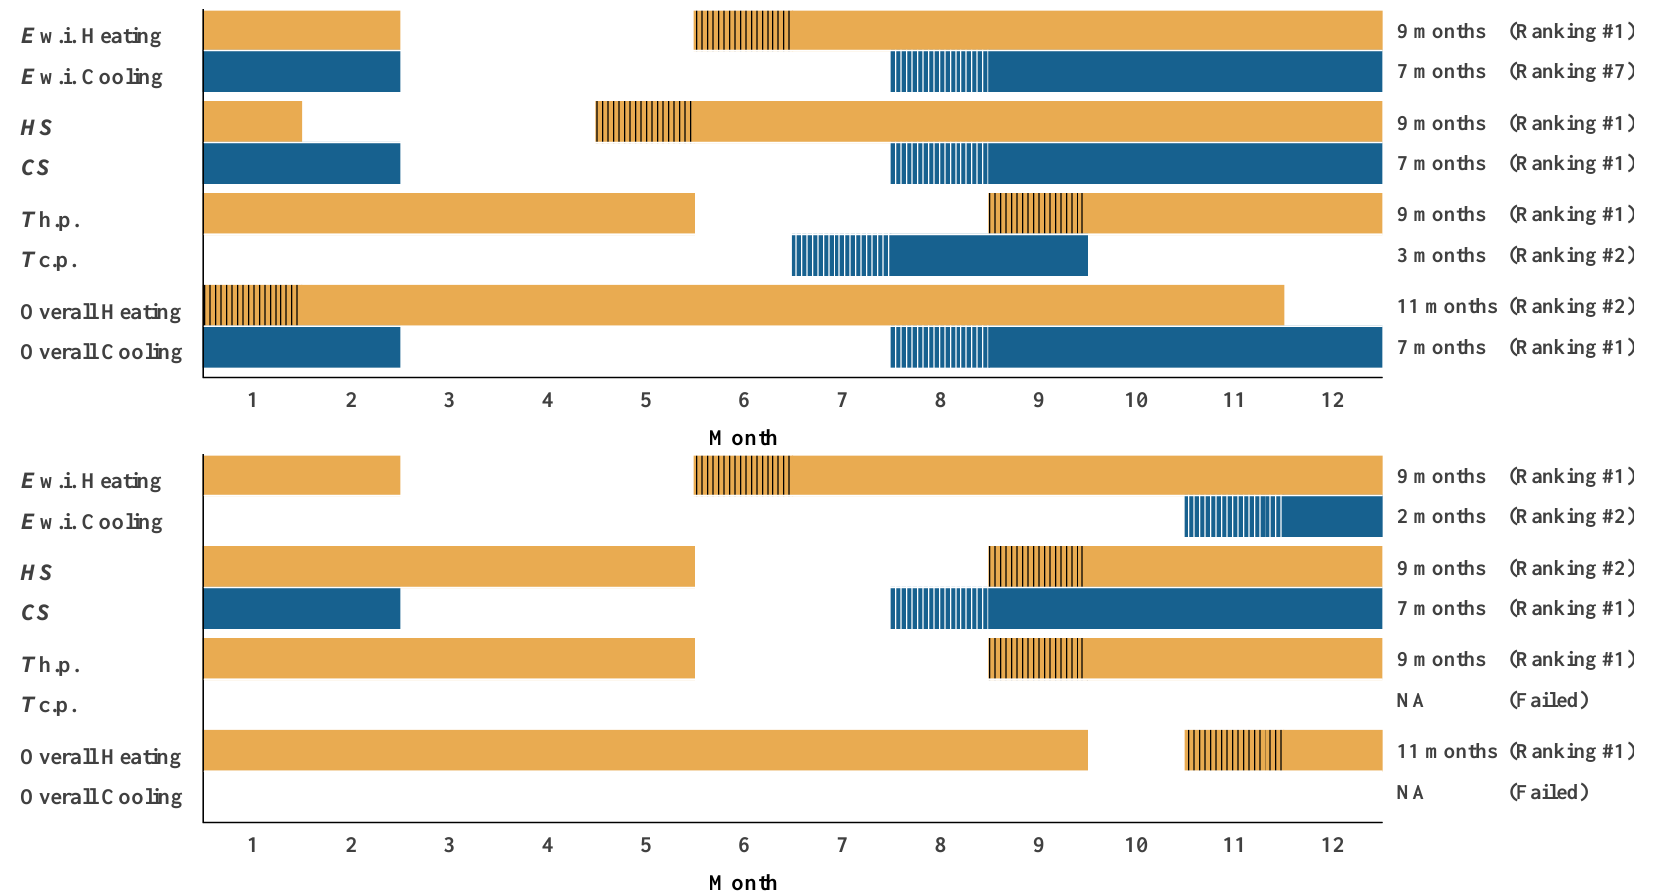
Figure 10. Comparison of the best periods for unit #301 (upper) and unit #304 (lower).